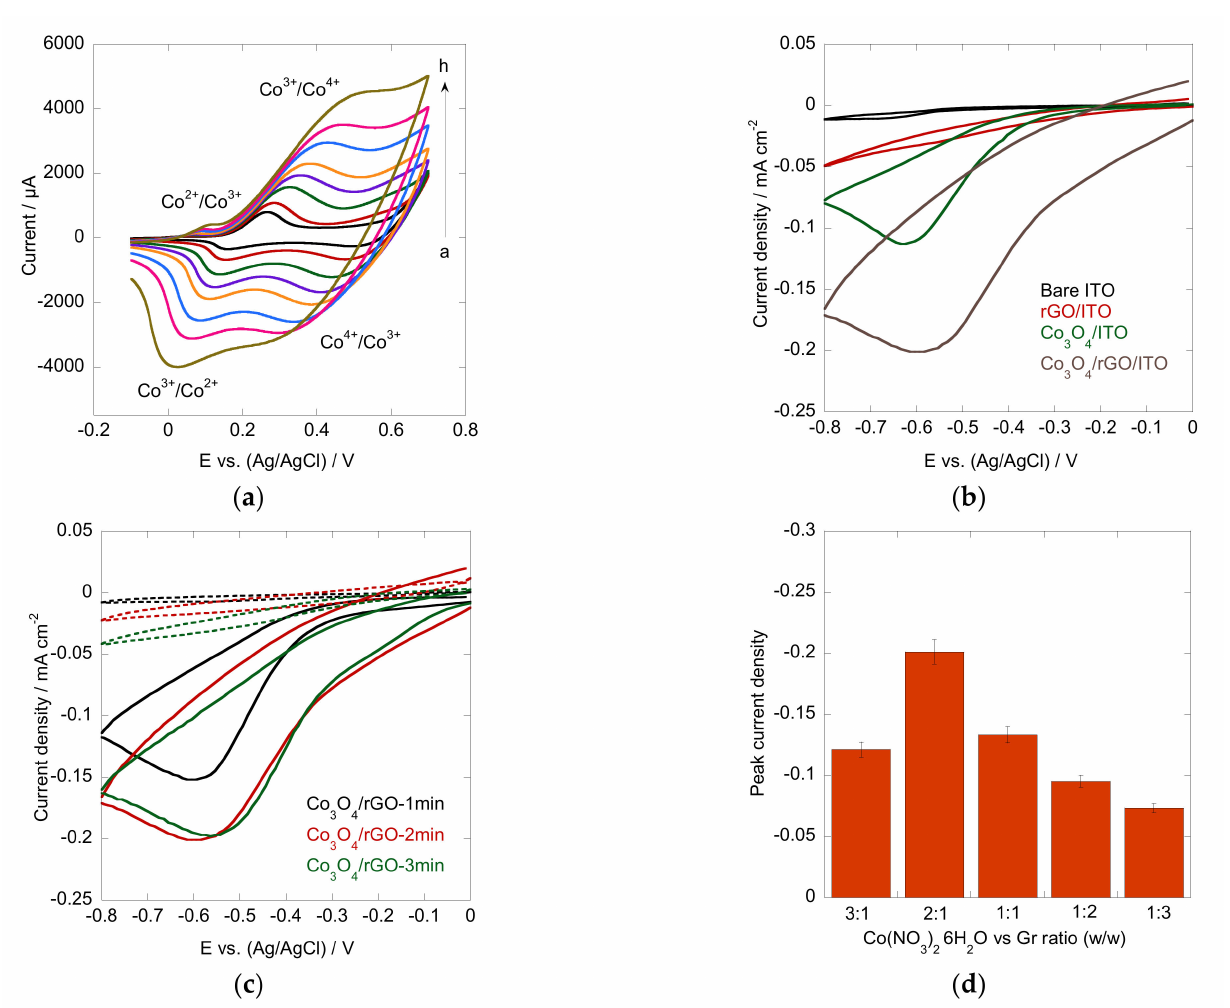
Figure 5. ( a ) CV scans of Co 3 O 4 /rGO in 0.1 M NaOH at different scan rates (a-h: 10–300 mV s − 1 ); ( b ) CV of bare ITO (black), rGO/ITO (red), Co 3 O 4 /ITO (green), and Co 3 O 4 /rGO (grey) in the presence of 1 mM H 2 O 2 in N 2 -saturated 0.1 M PBS buffer (pH = 7.4) at a scan rate of 50 mV s − 1 ; ( c ) CV of Co 3 O 4 /rGO-1min (black), Co 3 O 4 /rGO-2min (red), and Co 3 O 4 /rGO-3min (green) in the absence (dashed line) and presence (solid line) of 1 mM H 2 O 2 in N 2 -saturated 0.1 M PBS buffer (pH = 7.4) at a scan rate of 50 mV s − 1 ; ( d ) effect of varied ratios of Co 2+ vs.